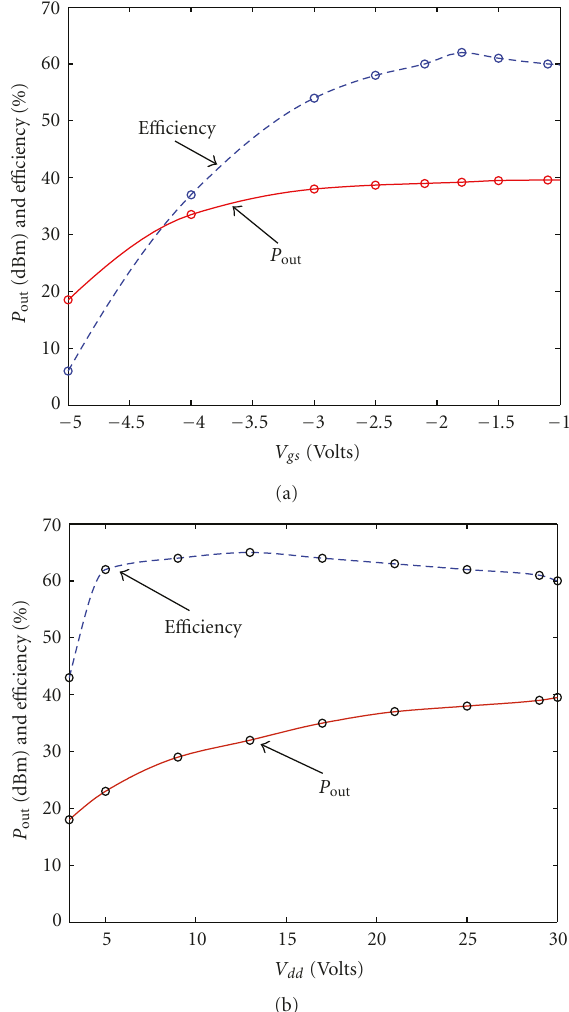
Figure 7: Measurement results. Output power and drain e ffi ciency for (a) PWM-like operation and (b) EER